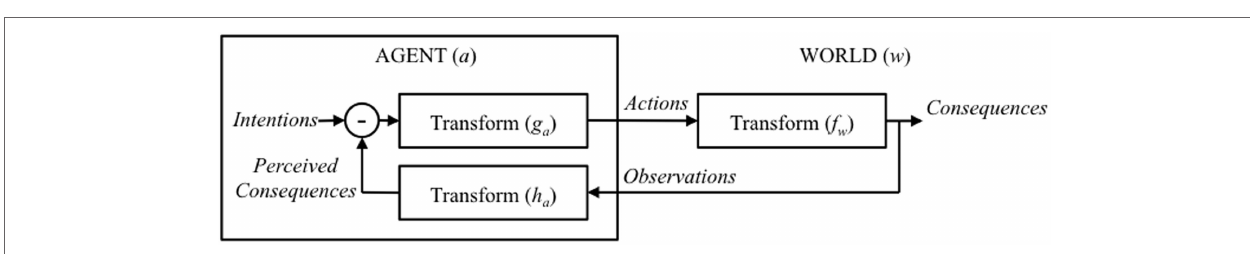
Frontiers in Robotics and AI |